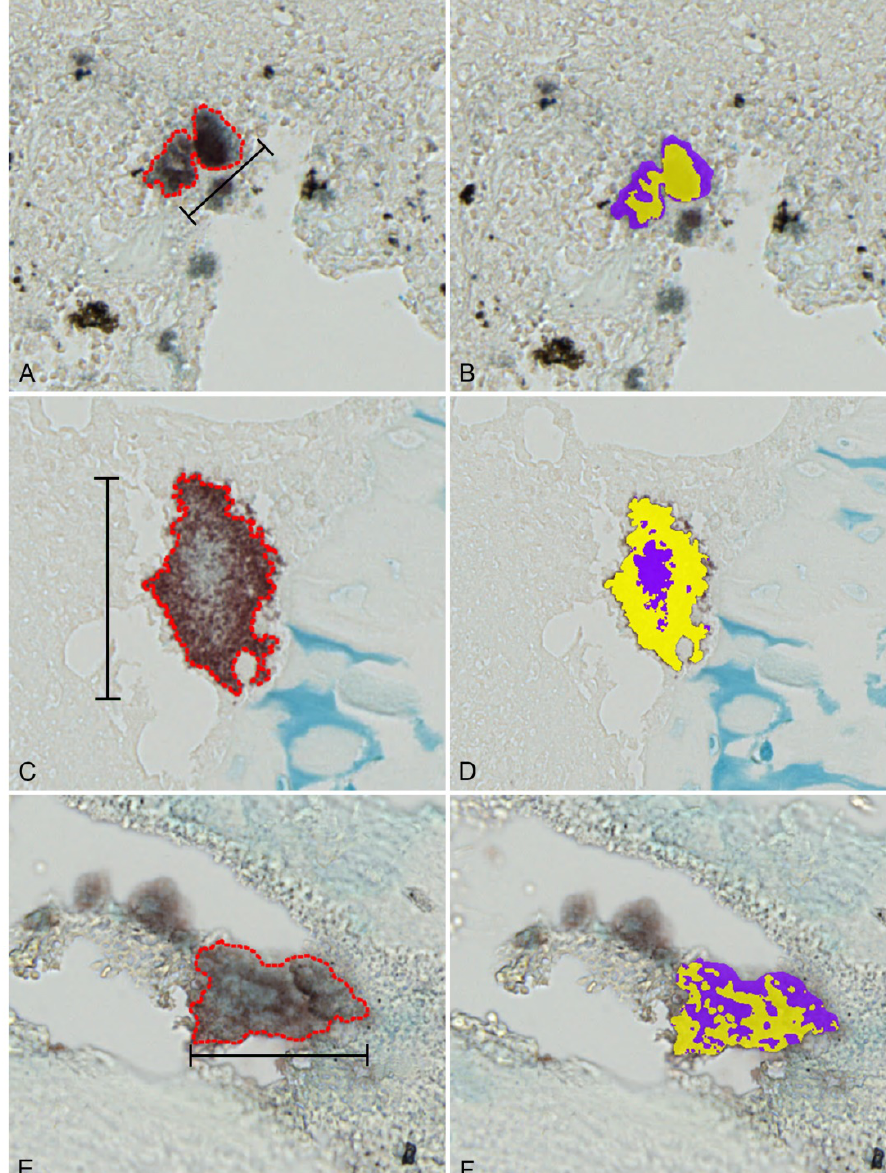
Figure 5. Percentage of bacteria and extracellular matrix in S. aureus biofilm infections. Left column: combined immunohistochemistry (towards S. aureus ) and Alcian blue pH3 staining of representative bacterial biofilms (red outline) displaying both bacteria (red/brown) and extracellular matrix(blue). Right column demonstrates calculations of % bacterial cells (yellow) and extracellular matrix (purple). A+B: Bone tissue from a porcine model of S. aureus implant-associated osteomyelitis infected for five days. Bar = 40 µ m. C+D: Bone tissue from a porcine model of S. aureus haematogenous osteomyelitis infected for fifteen days. Bar = 78 µ m. E+F: Bone tissue from a patient suffering from S. aureus haematogenous osteomyelitis for more than one year. Bar = 72 µ